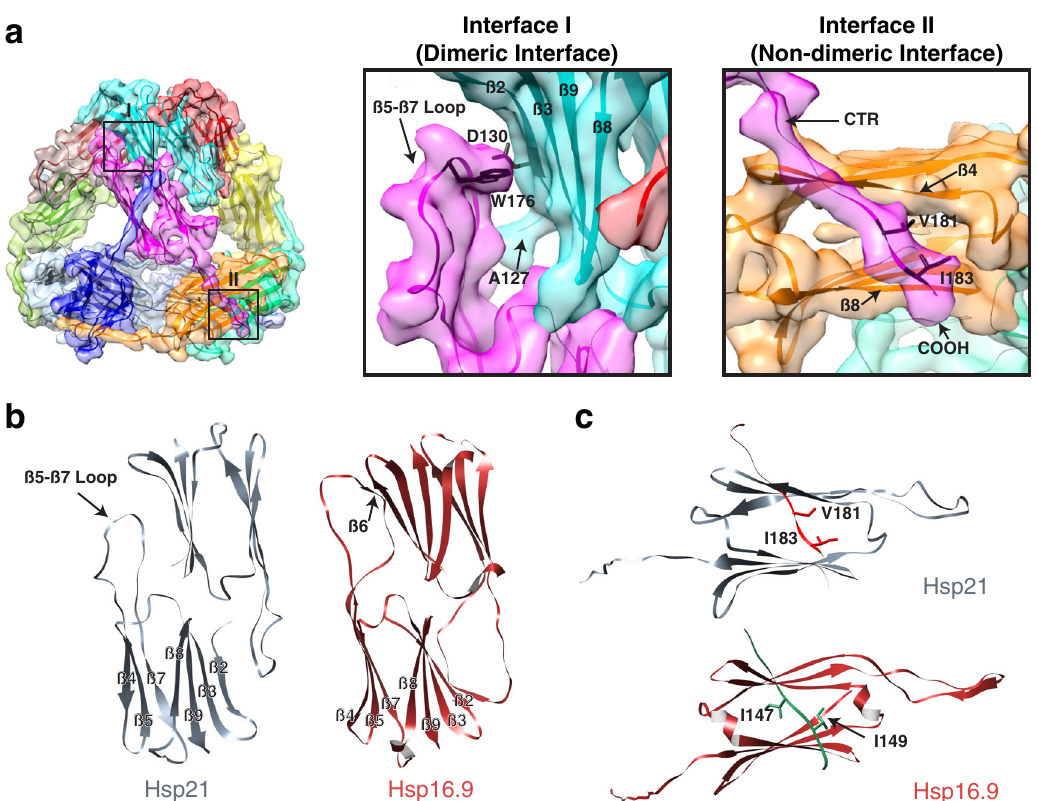
Fig. 3 Structure of the Hsp21 dodecamer, molecular details of Hsp21 oligomerization and comparison to Triticum aestivum Hsp16.9. a Cryo-EM map of the His-Hsp21 dodecamer with the fi tted model. Each subunit is shown in a different color. Interface I (Dimeric interface) and II (Non-dimeric interface) are indicated (black boxes) with the corresponding zoomed-in views shown on the right. The putative interacting residues on opposite subunits (D130 and W176) through limited hydrogen bonding are labeled. The fi rst residue of the ACD (A127) on one subunit presumably also contributing to Hsp21 dimerization is labeled. b Comparison of the dimers of Hsp21 (gray) and T. aestivum Hsp16.9 (brown) (PDB 1GME). β 6 is missing in Hsp21 and Hsp21 does not form reciprocal swapped dimers. Residues 215 – 227 on Hsp21 and residues 1 – 42 and 137 – 151 on Hsp16.9 are deleted for clarity. c Comparison of the non-dimeric interfaces of Hsp21 and Hsp16.9. Only residues 218 – 227 on Hsp21 (red) and residues 143 – 151 on Hsp16.9 (green) of the neighboring subunit are shown for clarity. For Hsp21, the residues V181 and I183 of the IXVXI (residues 179 – 183) oligmerization motif are labeled. For Hsp16.9, the residues I147 and I149 on the IXI (residues 147 – 149) of oligomerization motif are (Fig. 3a, right, and c). In the Hsp21-DXPS structure, residues in the segment 318 – 322 of DXPS bind to the hydrophobic groove on the opposite side of this β -sandwich (Fig. 2b), despite utilizing a similar binding mode.